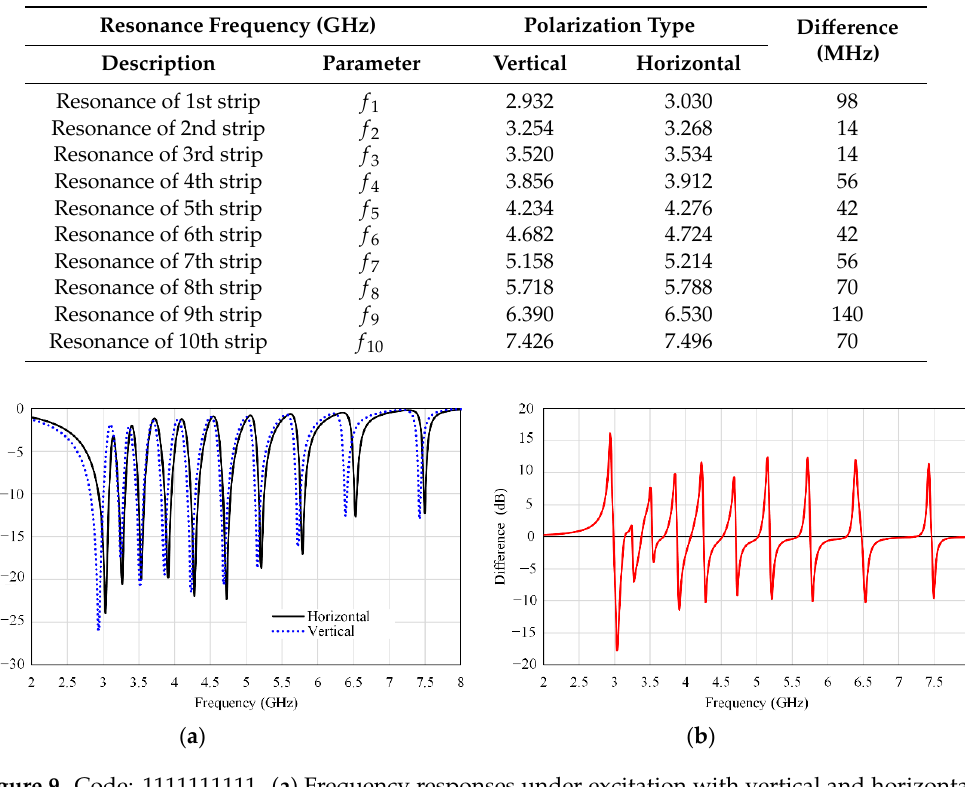
Table 2. Possible frequencies for the all-ones code with vertical and horizontal polarizations.